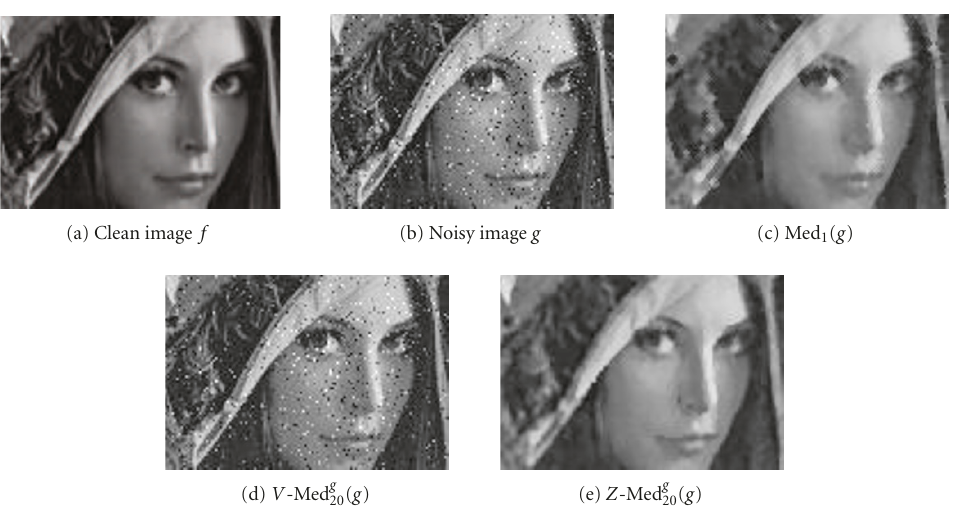
Figure 8: Image restoration. Image (a) is corrupted with a 10% uniformly distributed impulse noise (b). Median filtering is used to filter the noisy image: usual filtered image (c) with a disk of radius 1 as operational window, adaptive median filtered image (d) with V g 20 ( ). The most e ffi cient denoising is supplied by the C-LANs and adaptive filtered image (e) with Z f 20 ( (cid:5)